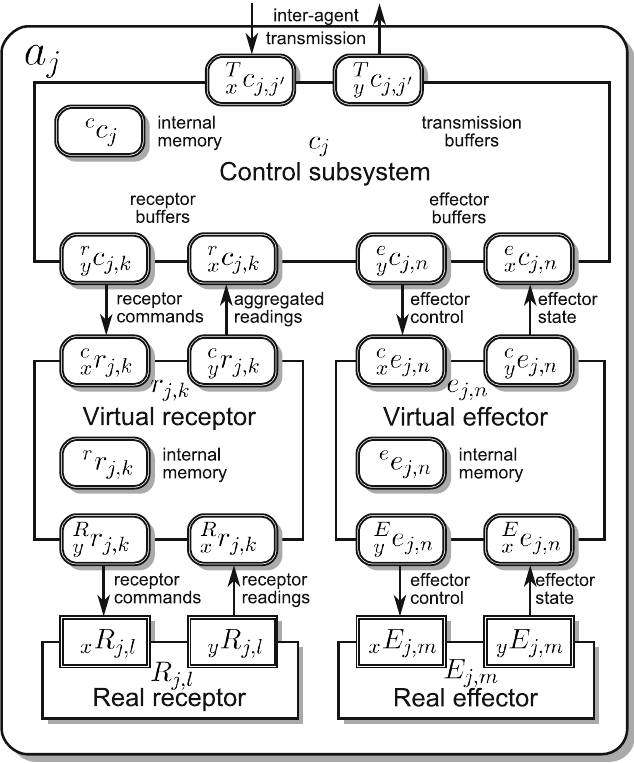
Figure 1. Internal structure of an agent a j